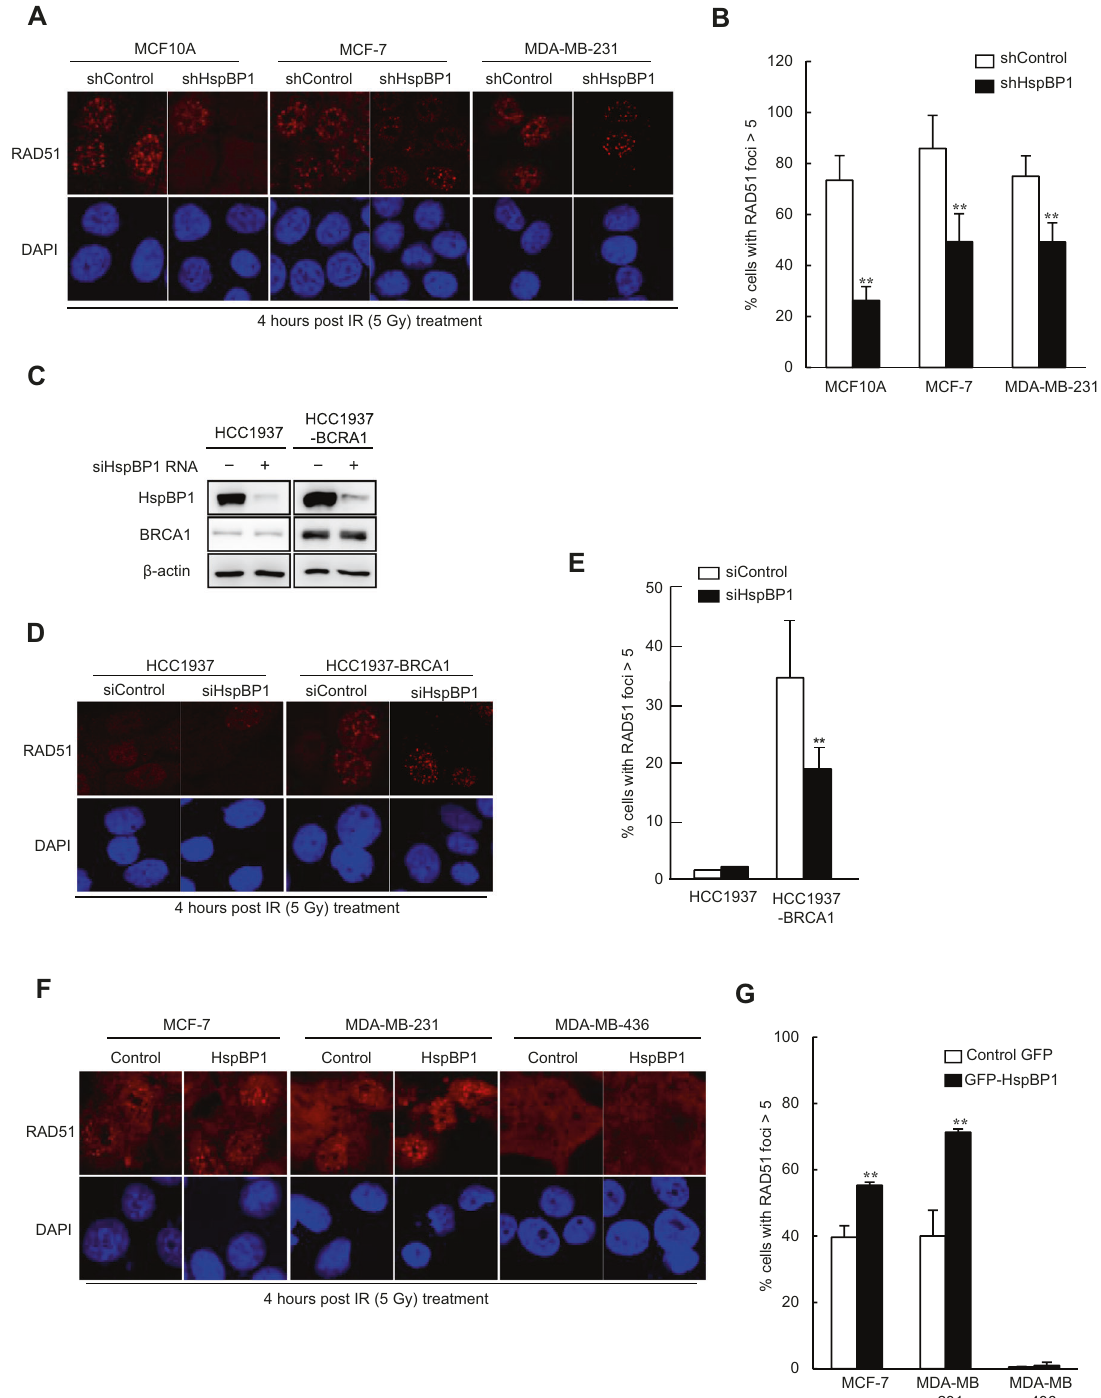
Fig. 5 HspBP1 regulates Rad51 foci in response to IR in breast cancer cells. A, B HspBP1-depleted non-malignant breast cancer cells (MCF10A) or BRCA1-pro fi cient breast cancer cells (MCF7, and MDC-MB-231) and corresponding control cell lines were irradiated with 5 Gy of IR and fi xed at 1 h after irradiation. Immuno fl uorescence analysis with antibodies against Rad51 was then carried out. Nuclei were stained with DAPI. Representative images ( A ) and the percentage of cells with more than 5 foci for Rad51( B ) are shown. Data represent mean ± SD ( n = 3), ** P < 0.01, two-tailed Student ’ s t -test. C The levels of HspBP1 in control and BRCA1-reconstituted HCC1937 cells transfected with either control or HspBP1 siRNA. D, E The levels of IR-induced Rad51 foci were measured in control and BRCA1-reconstituted HCC1937 cells transfected with either control or HspBP1 siRNA as described in ( A ). Representative images ( C ) and quanti fi cation ( D ) of Rad51 foci are shown. Data represent mean ± SD ( n = 3), ** P < 0.01, two-tailed Student ’ s t -test. F, G The levels of IR-induced Rad51 foci were measured in GFP-HspBP1-expressing MCF7, MDC-MB-231, MDA-MB-436 cells and the corresponding control cells as described in ( A ). Representative images ( F ) and quanti fi cation ( G ) of Rad51 foci are shown. Data represent mean ± SD ( n = 3), ** P < 0.01, two-tailed Student ’ s t-test.